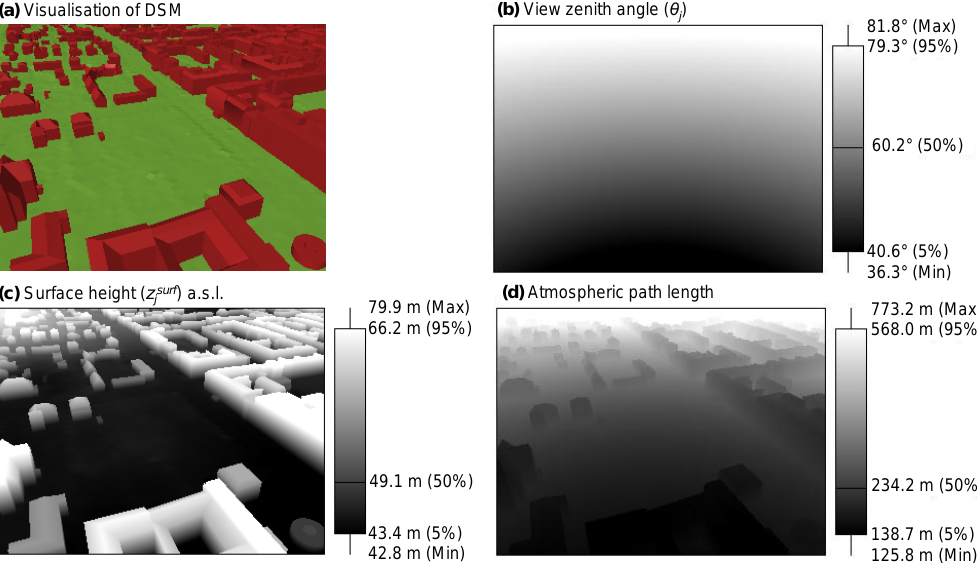
Fig. 5. (a) Perspective projection of the DSM, spatial distribution of LOS geometry parameters: (b) view zenith angle θ j , (c) surface height z surf and (d) atmospheric path j